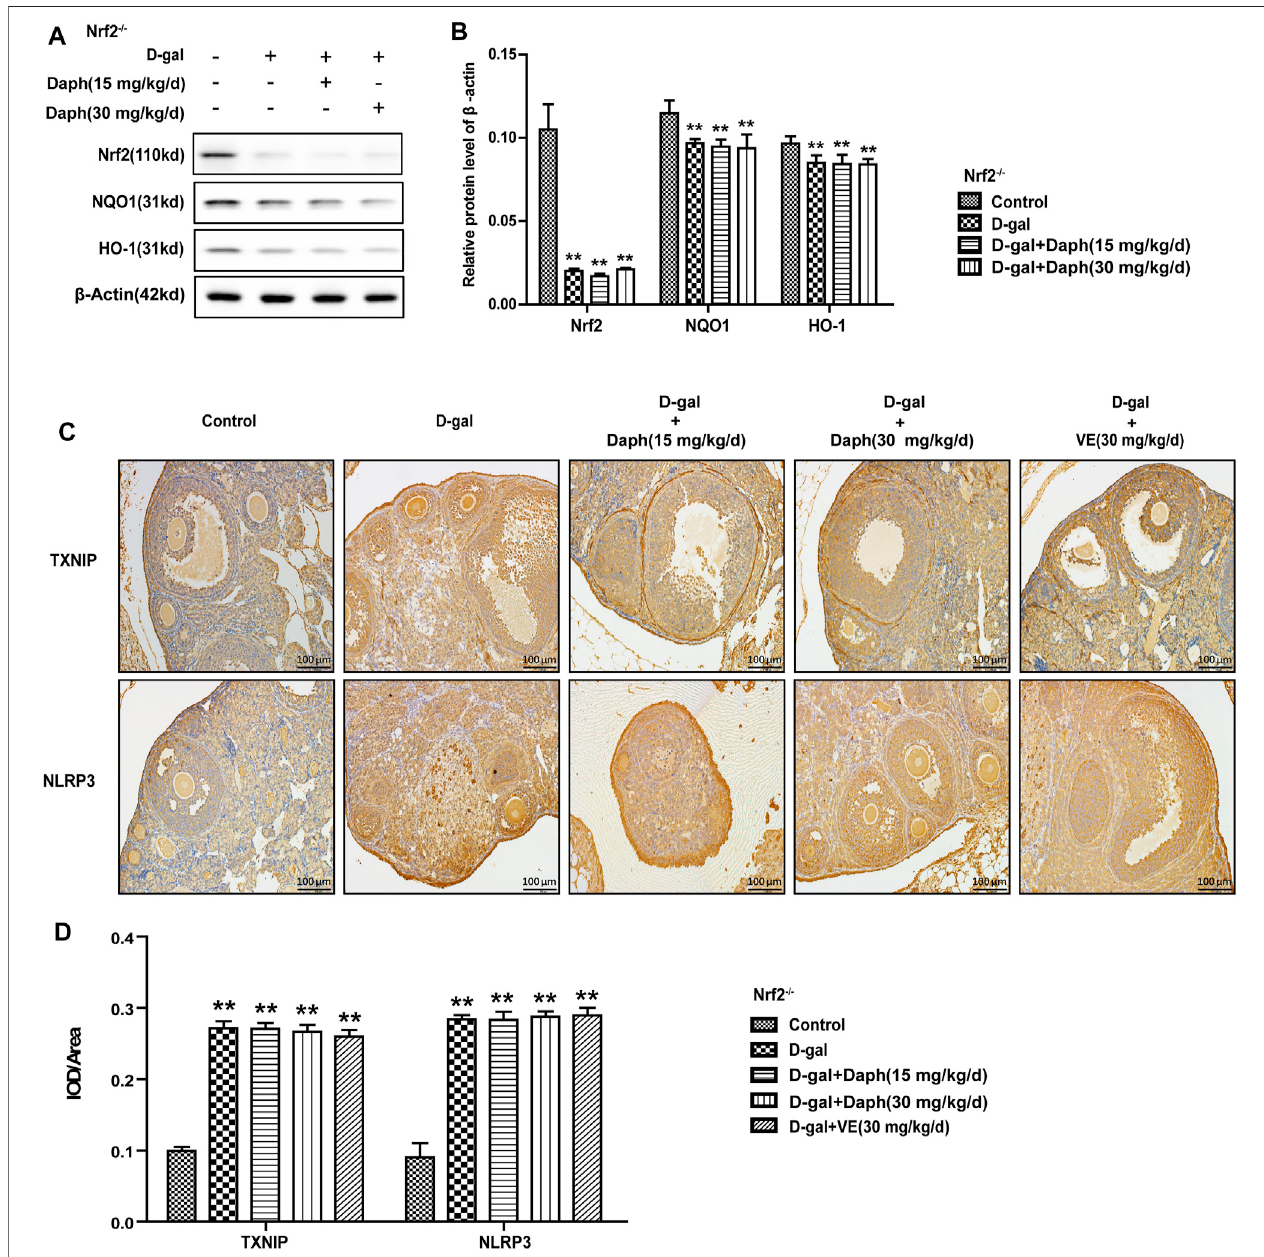
FIGURE 8 | Knockout of Nrf2 abolished the adjustive power of Daph on oxidative stress-related pathways. (A,B) The Nrf2, NQO1 and HO-1 protein expression levels in ovarian tissues were tested by Western blotting. (C,D) TXNIP and NLPR3 protein expression level analysis via immunohistochemistry. The data in (A,B) are shown as means ± SEMs, n = 3. The data in (C,D) are shown as means ± SEMs, n = 5. Statistical signi fi cance: ** p < 0.01.